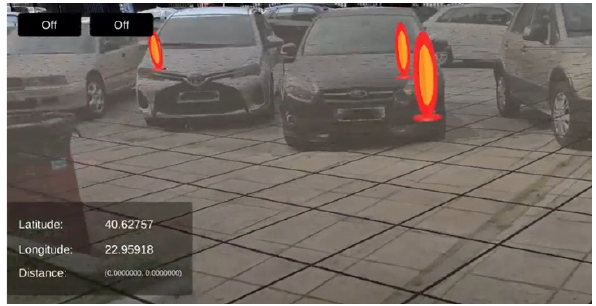
Figure 5 : Lack of occlusion